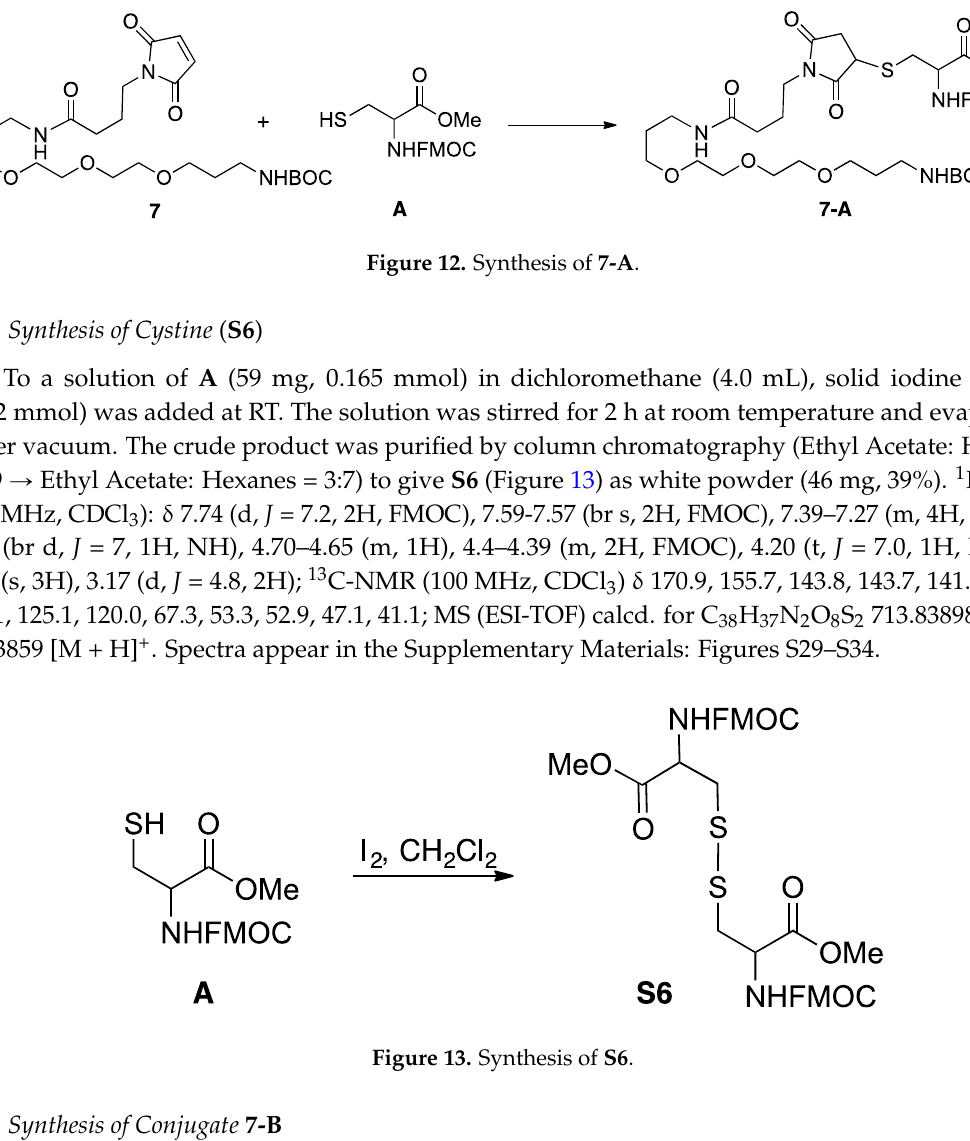
Figure 9. Synthesis of 7 . 3.9. Synthesis of Conjugate 7-A To a solution of 1 (35 mg, 0.07 mmol) in dioxane (1.0 mL) a solution of cysteine A (28 mg, 0.079) in dichloromethane (1.0 mL) was added at RT. The solution was stirred for 48h at room temperature and evaporated under vacuum. The crude product was purified by column chromatography (DCM = 100 → DCM:MeOH = 95:5) to give 7-A (Figure 10) as a oil (37 mg, 61%). 1 H-NMR (400 MHz, CDCl 3 ): δ 7.76 (d, J = 8.0, 2H, FMOC), 7.61 (t, J = 6.0, 2H, FMOC), 7.42–7.28 (m, 4H, FMOC), 5.00 (br s, 1H, NH), 4.71–4.68 (m, 1H, p), 4.49–4.41 (m, 2H, FMOC), 4.24 (t, J = 6.8 , 1H, FMOC), 3.83–3.75 (m, 1H, n), 3.80 (s, 3H, q), 3.65–3.51 (m, 14H, c, d, e, f, g, h, m), 3.46 (dd, J = 14, 6.0, 1H, o), 3.37–3.31 (m, 2H, j), 3.23–3.19 (m, 2H, a), 3.15–3.03 (m, 2H, n’, o), 2.50–2.39 (m, 1H, n’), 2.15 (t, J = 7.2, 2H, k), 1.99–1.90